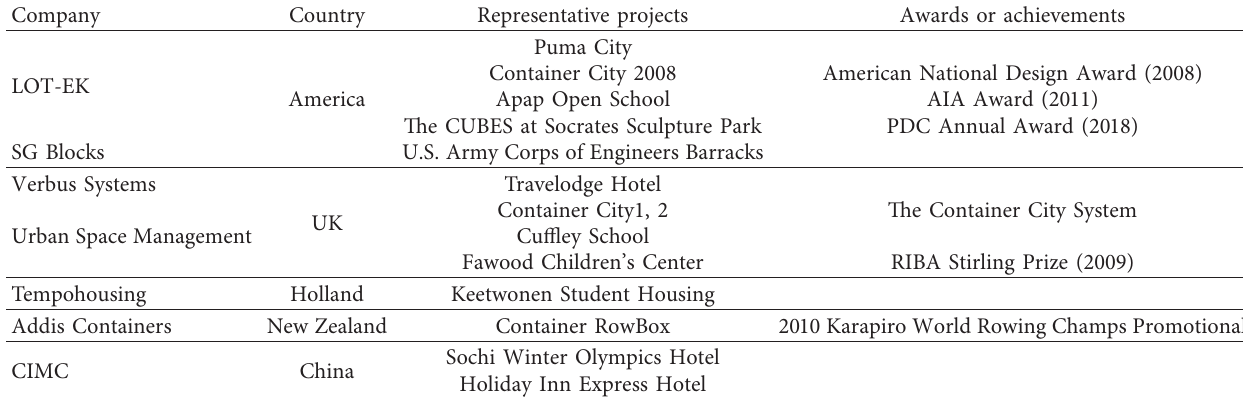
Table 1: Famous container design and manufacturing company and its